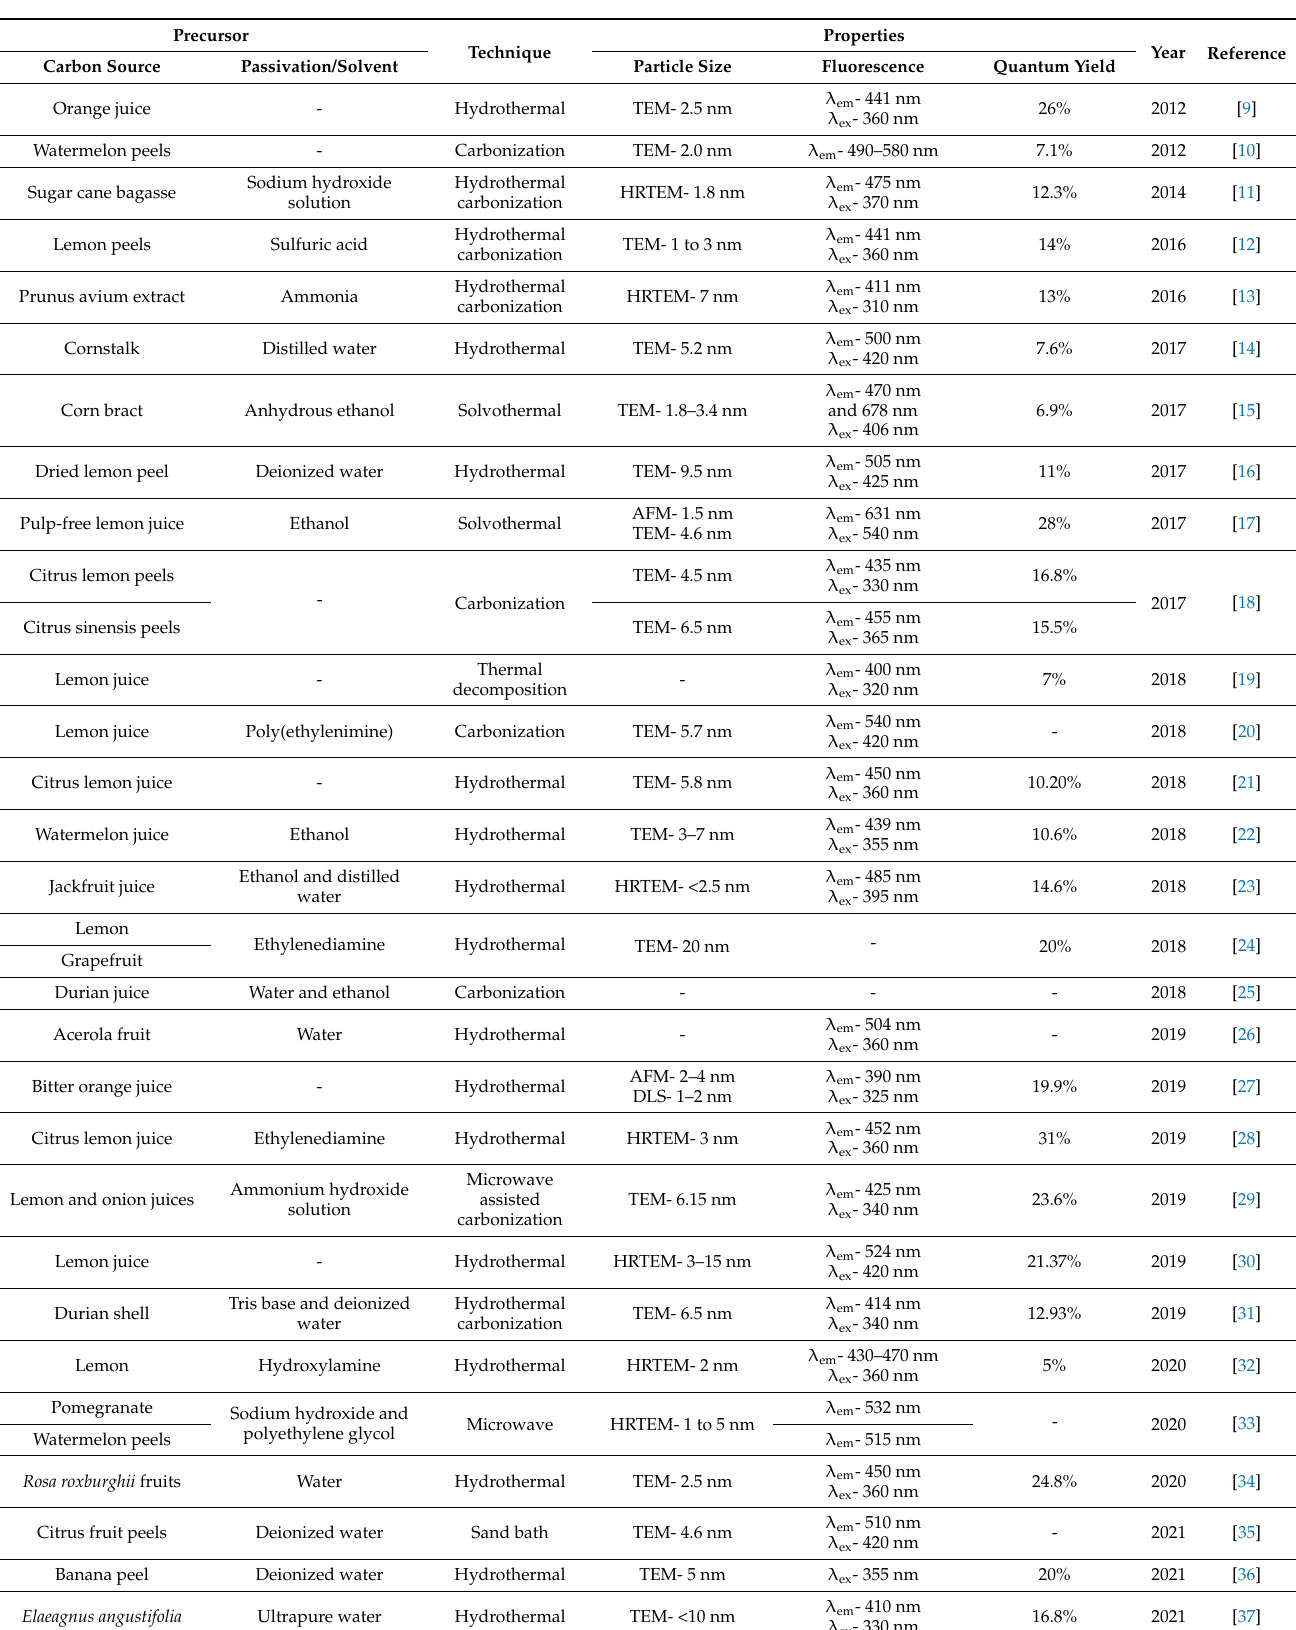
Table 1. Summary of the synthesis CDs from